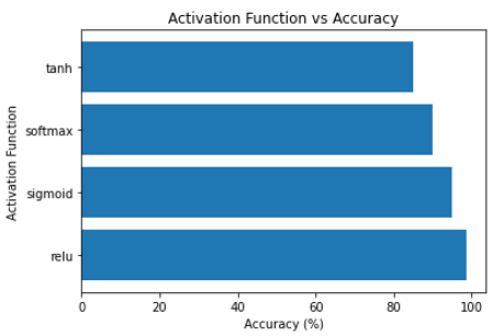
Figure 8. Activation Functions used against their corresponding